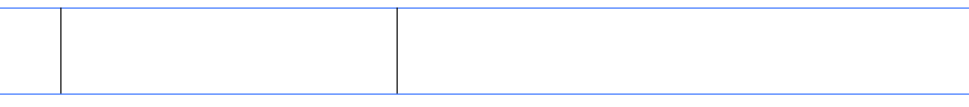
Fig. 4. The frequency of use of the concept of ‘condition’ (source No. 17) (Developed by the author using AntConc